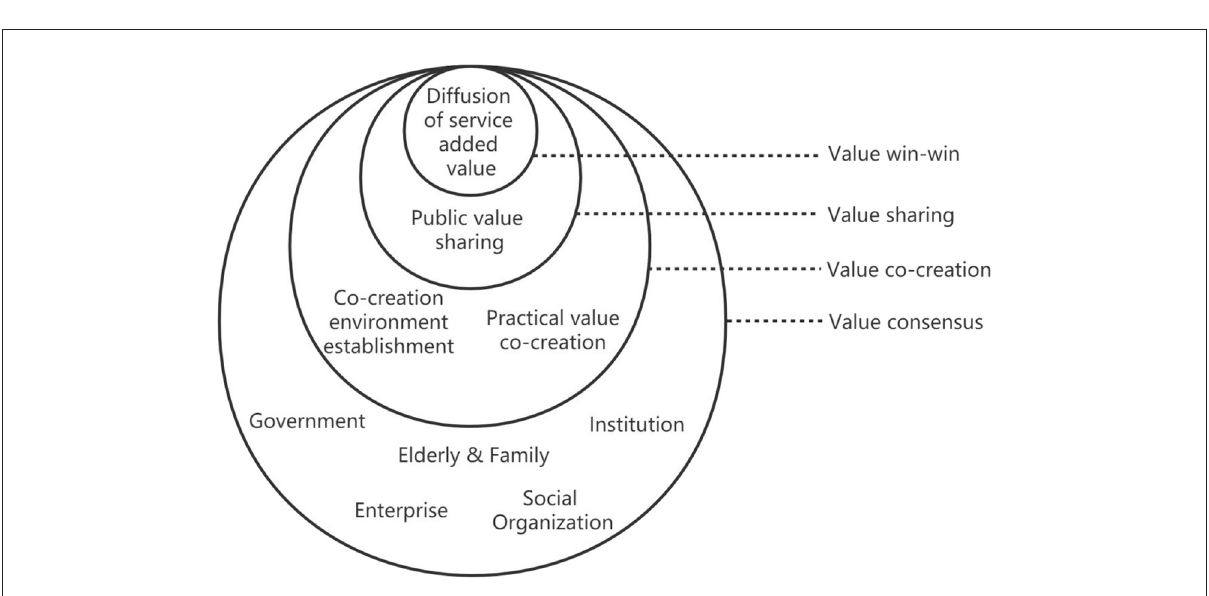
FIGURE1 Conceptual model of SSC value co-creation.